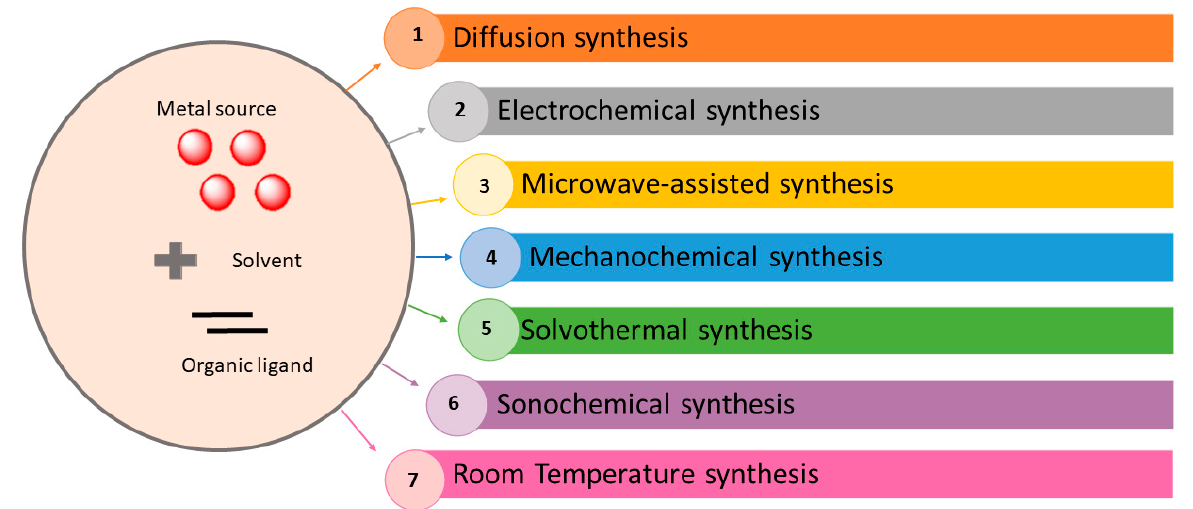
Figure 4. MOF synthesis methods.